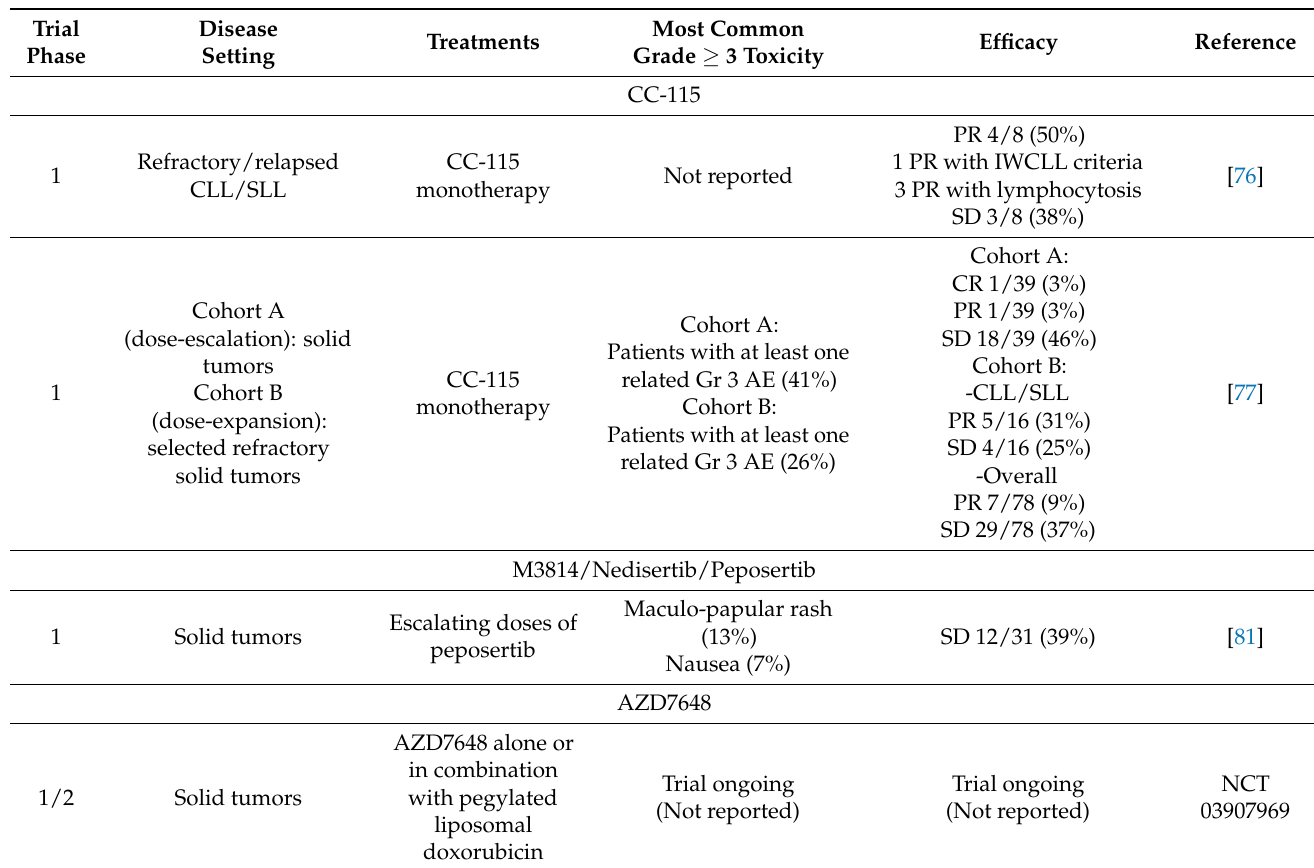
Table 2. Clinical trials of DNA-PK